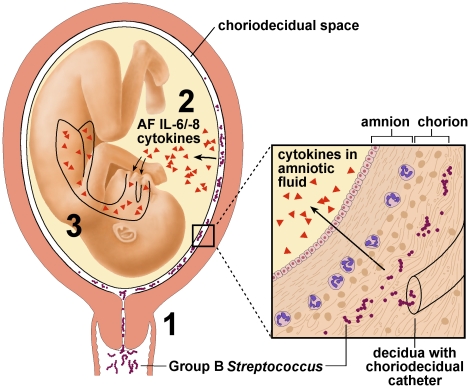
Our conceptual model.1. Bacteria from the lower genital tract ascends into the choriodecidual space. 2. Inflammatory mediators (e.g. IL-8) produced by decidua and/or membranes diffuse into amniotic fluid and the fetal lung. 3. Fetal lung injury is induced by inflammatory mediators. IL, Interleukin; AF, amniotic fluid.